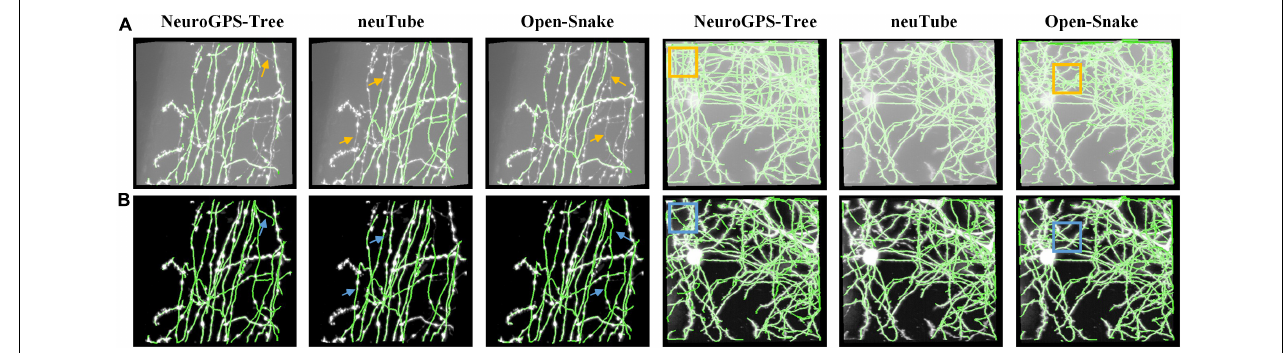
FIGURE 5 | RSSM facilitates the usage of some typical quantitative software tools. (A) Two fMOST neuronal images and their corresponding tracing results by software NeuroGPS-Tree, neuTube, and Open-Snake with selected parameters. (B) The estimated foreground images by RSSM and their corresponding tracing results by these tools with default parameters.